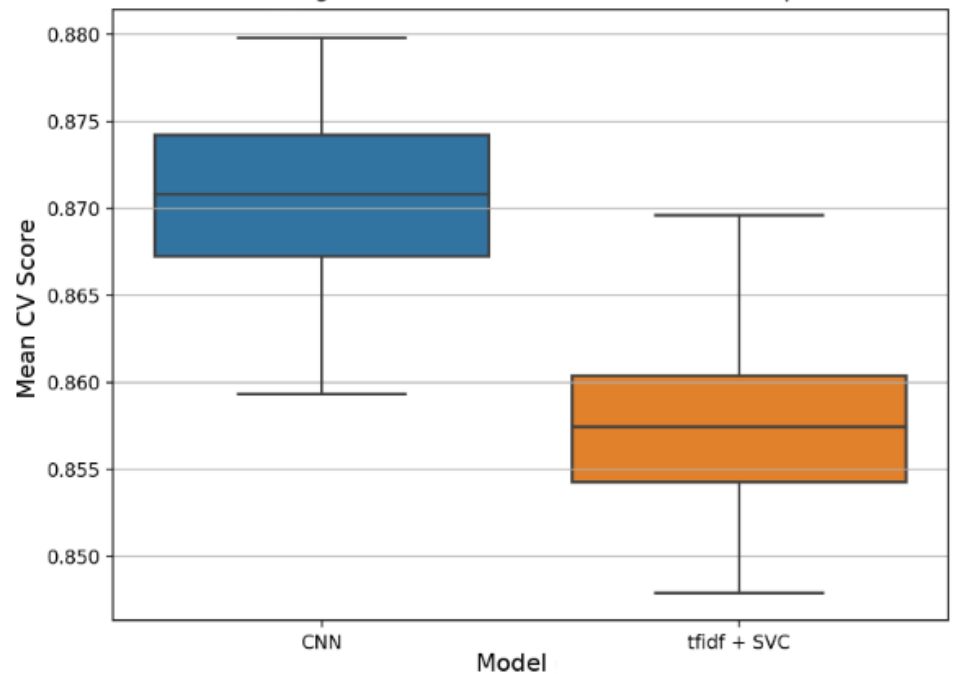
Figure 10. Convolutional Neural Network architecture including flattening layers.